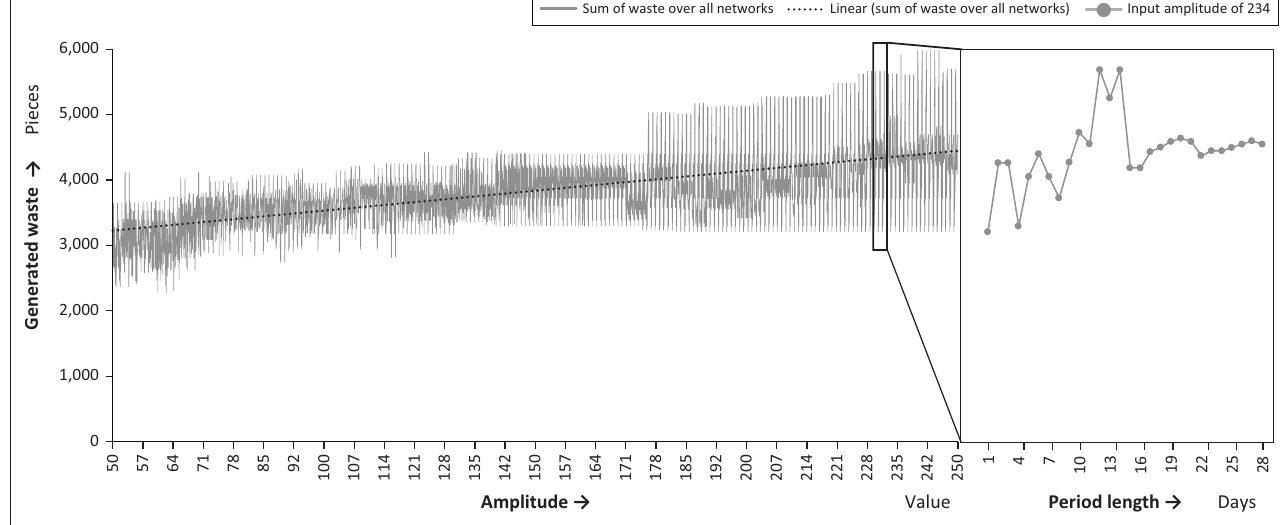
FIGURE 6: Left: Sum of the generated waste for each amplitude over every period length; Right: Zoom into exemplary waste-chart for amplitude of 234: Waste over period length.